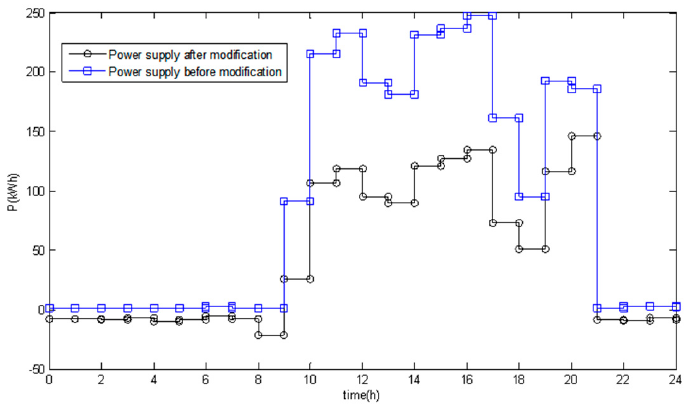
Figure 6. Output power of the grid. The output power of the wind turbines and their grey domain values are shown in Figure 7.